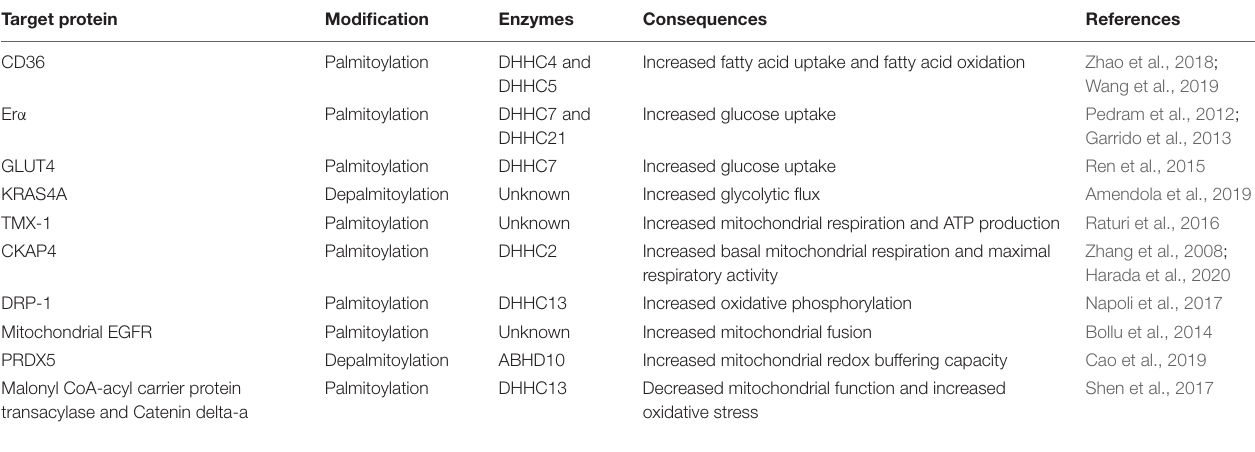
TABLE 1 | Summary of palmitoylation and depalmitoylation involvement in cancer metabolism. Target